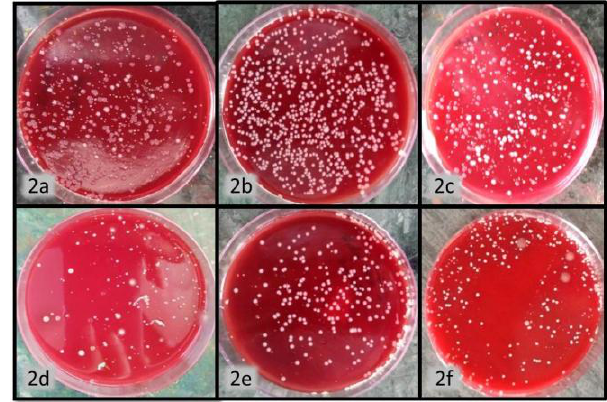
Figure 2: Figure 2a, b, c are baseline CFU A, B, C respectively. Figure 2d, e, f are postoperative CFU evaluated 3 month post-operatively for group A, B, C respectively. CFU: Colony forming